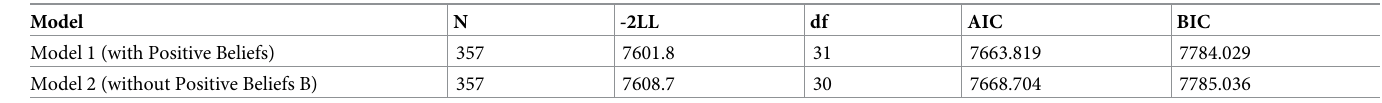
Table 6. Comparison of fit for generalised structural equation models.